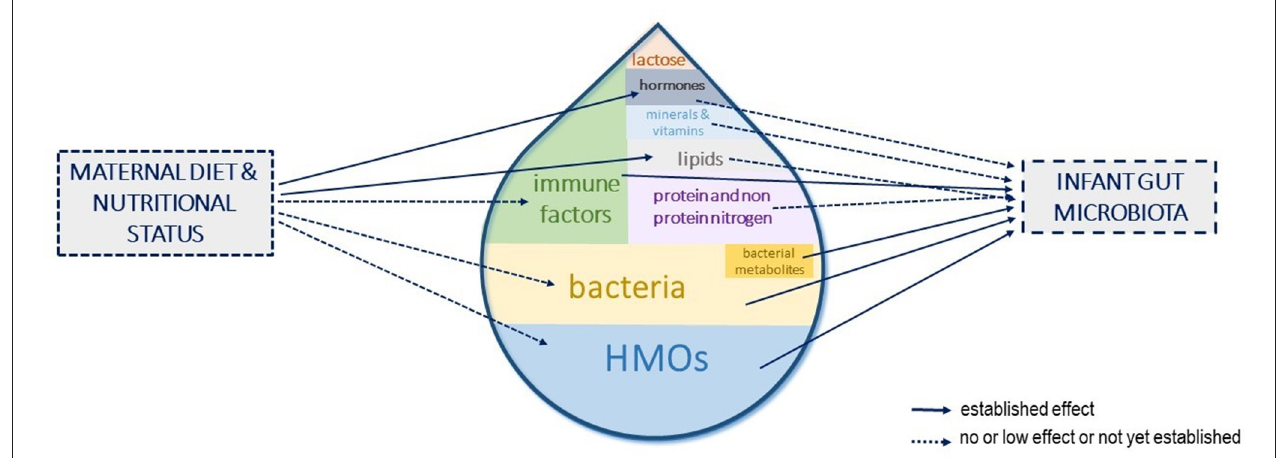
FIGURE 4 | Human milk components shaping the infant gut microbiota and influence of maternal diet and nutritional status. The different components of human milk (HM) that have been shown or are suspected to influence the infant gut microbiota establishment are represented. Their size in the milk drop is proportional to their suspected role in shaping the infant gut microbiota. The influence of maternal diet or nutritional status on these HM components concentrations is depicted with